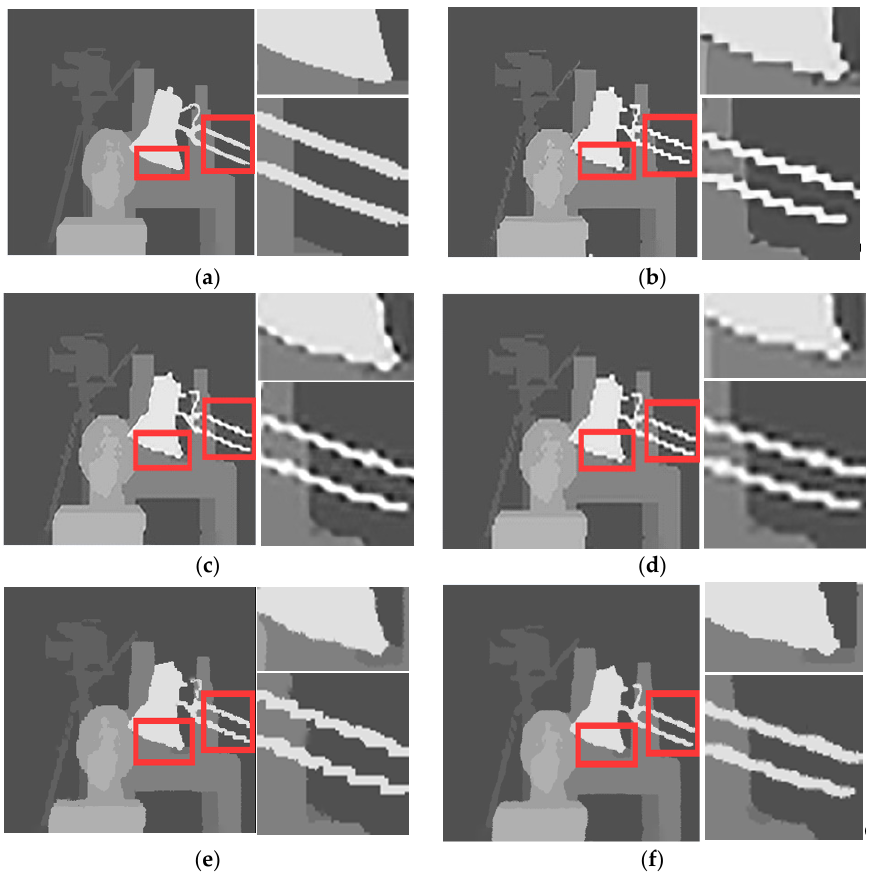
Figure 6. Visual comparisons of “tsukuba”: ( a ) ground truth (reprinted with permission from [38]); ( b